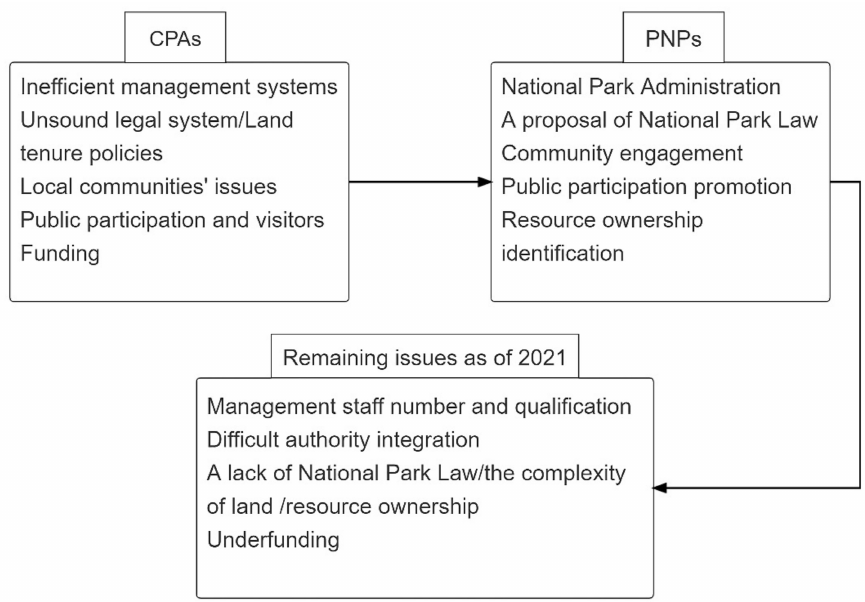
Figure 6. Issues of CPAs, countermeasures of PNPs, and remaining issues as of